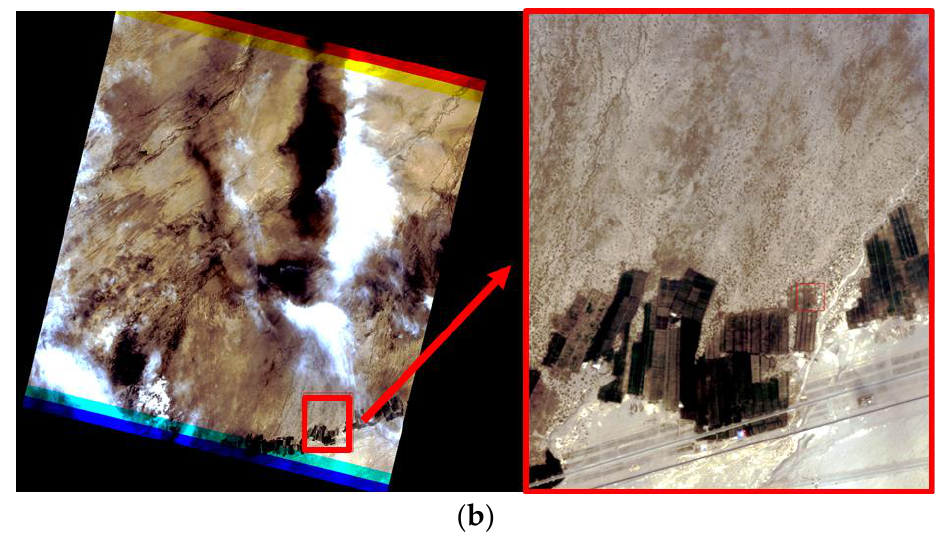
Figure 44. ( a ) Sentinel2A acquisition covering SNOCHINA site, 3 August 2020 04:57:01; ( b ) VEN µ S